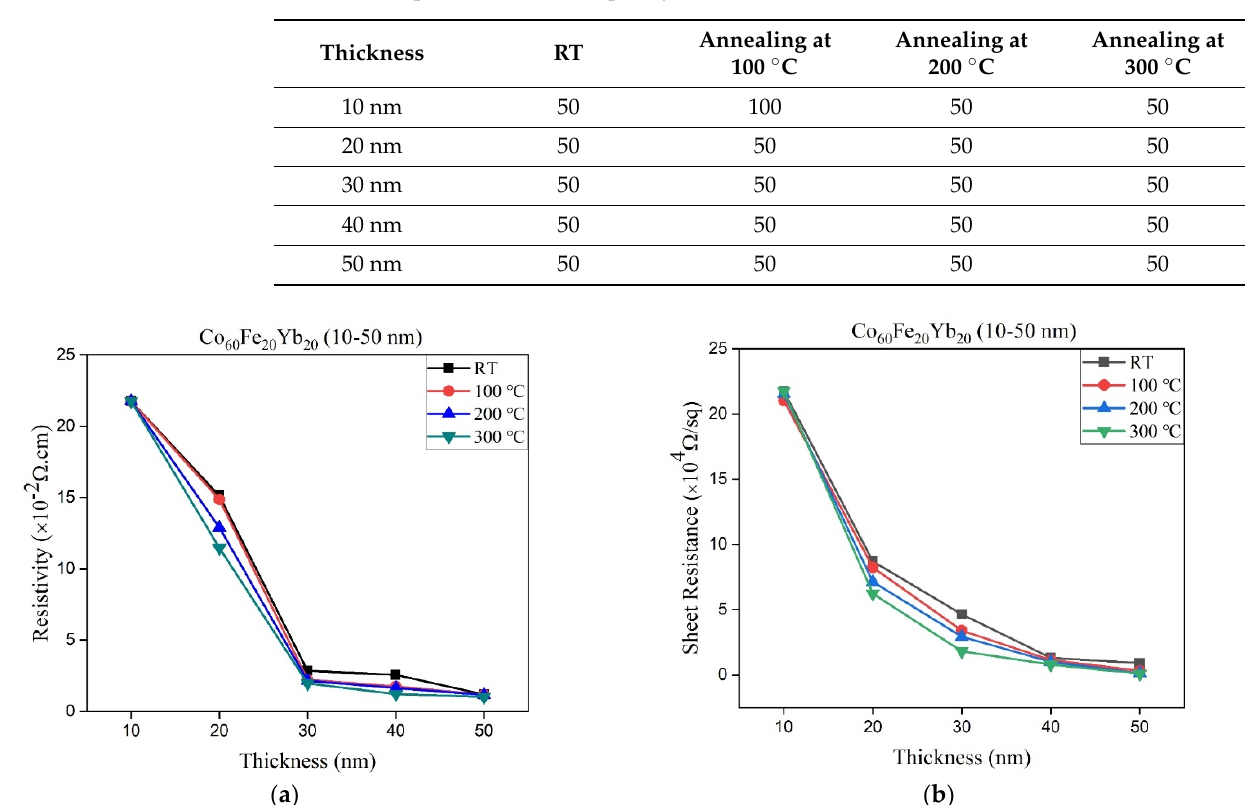
Figure 4. ( a ) The resistivity of CoFeYb thin films, ( b ) the sheet resistance of CoFeYb films.